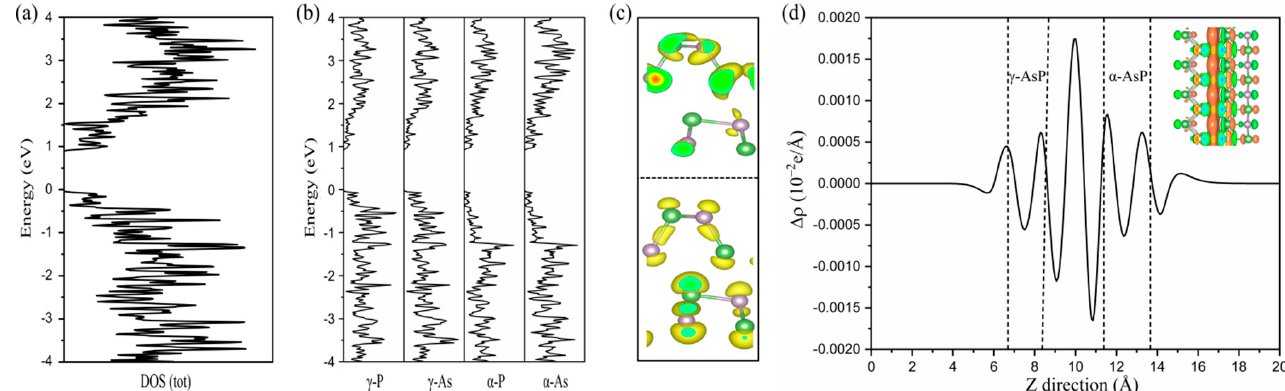
Figure 3. Density of states (DOS) ( a ) and projected density of states (PDOS) of the α -AsP/ γ -AsP homojunction ( b ). ( c ) Partial charge density of CBM and VBM. ( d ) The plane averaged differential charge density. The isosurface in green and orange represents the loss and gain of electrons, respectively. The above calculations are based on the calculations of HSE06 function.